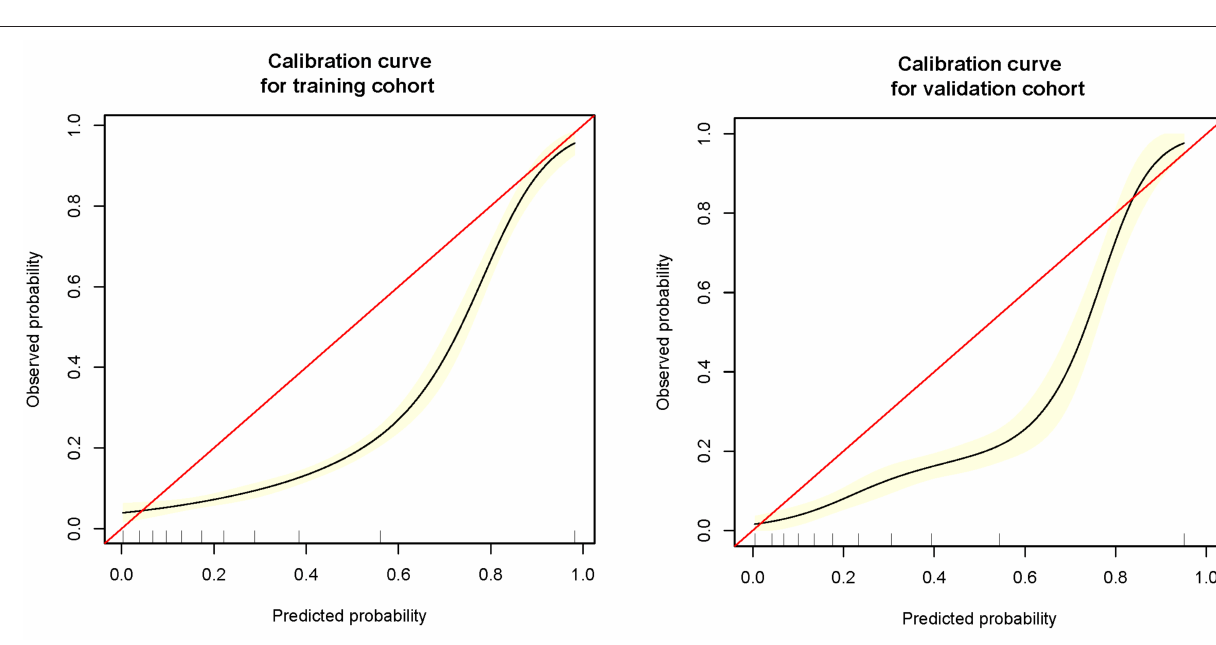
FIGURE 2 | The nomogram of the full